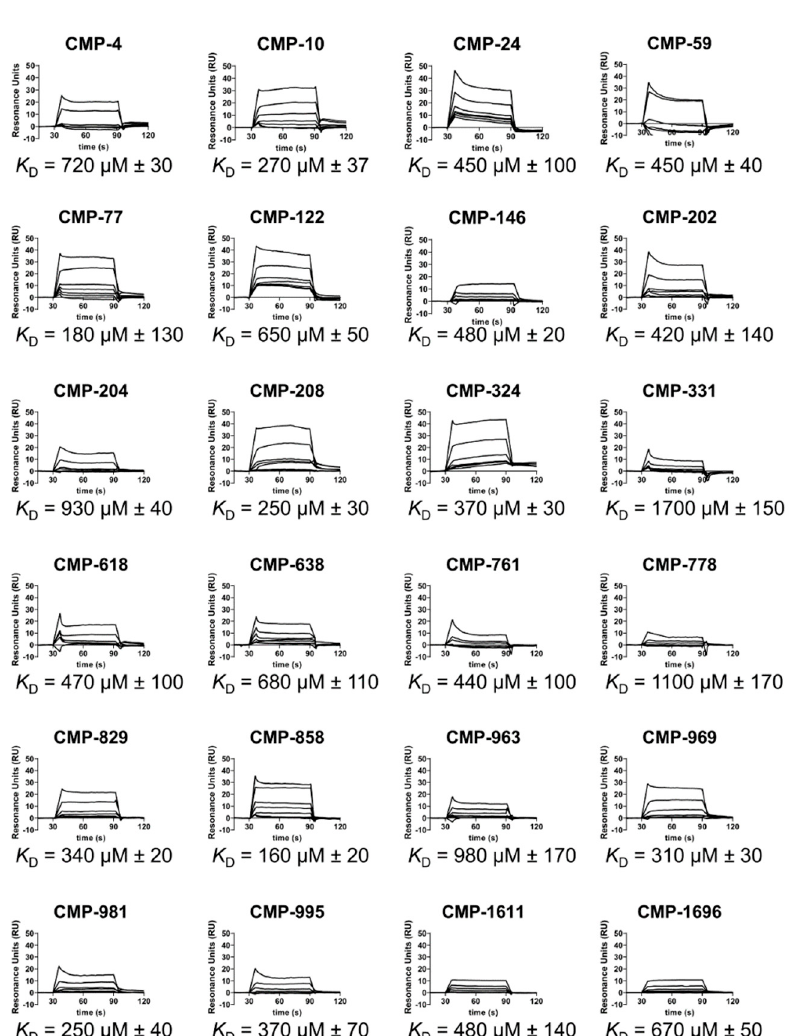
Figure 3. Dose-dependent binding of full-length C1r by selected hit compounds. Dose-dependent C1r binding for 24 compounds was measured by injecting a two-fold variable concentration series of each compound ranging from 7.8 to 500 µM. Steady-state affinities were calculated from the resulting sensorgrams. A representative set of sensorgrams are shown along with the associated steady-state K D values. The corresponding steady-state fits are shown in Figure S1. K D values are reported as the mean ± S.D. calculated from three independent injection series.